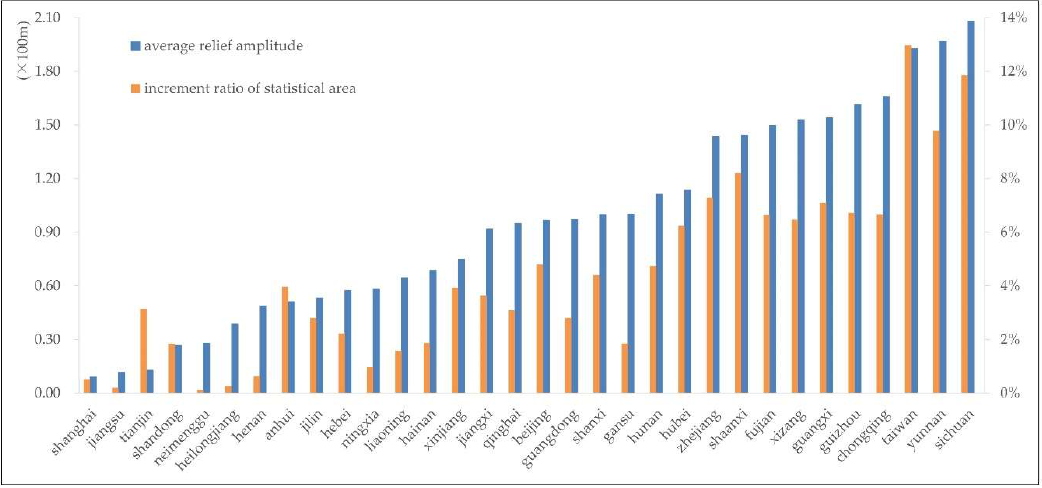
Figure 11. Comparison of the statistical area and surface area of forest of each province.